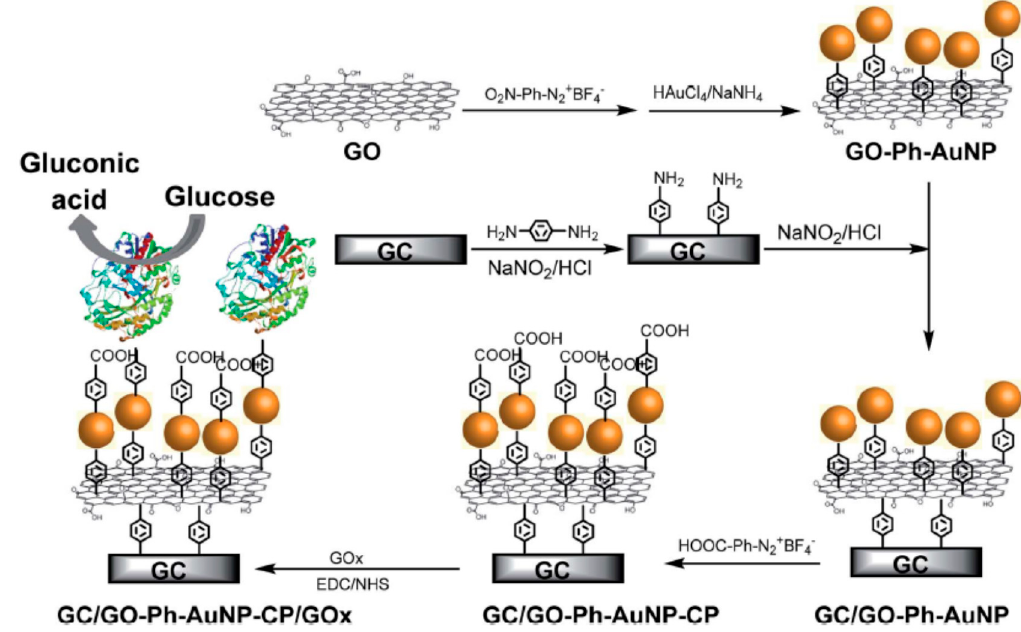
Figure 14. Attachment of glucose oxidase through graphene oxide and gold nanoparticles. From Reference [76] with permission of the Royal Chemical Society.